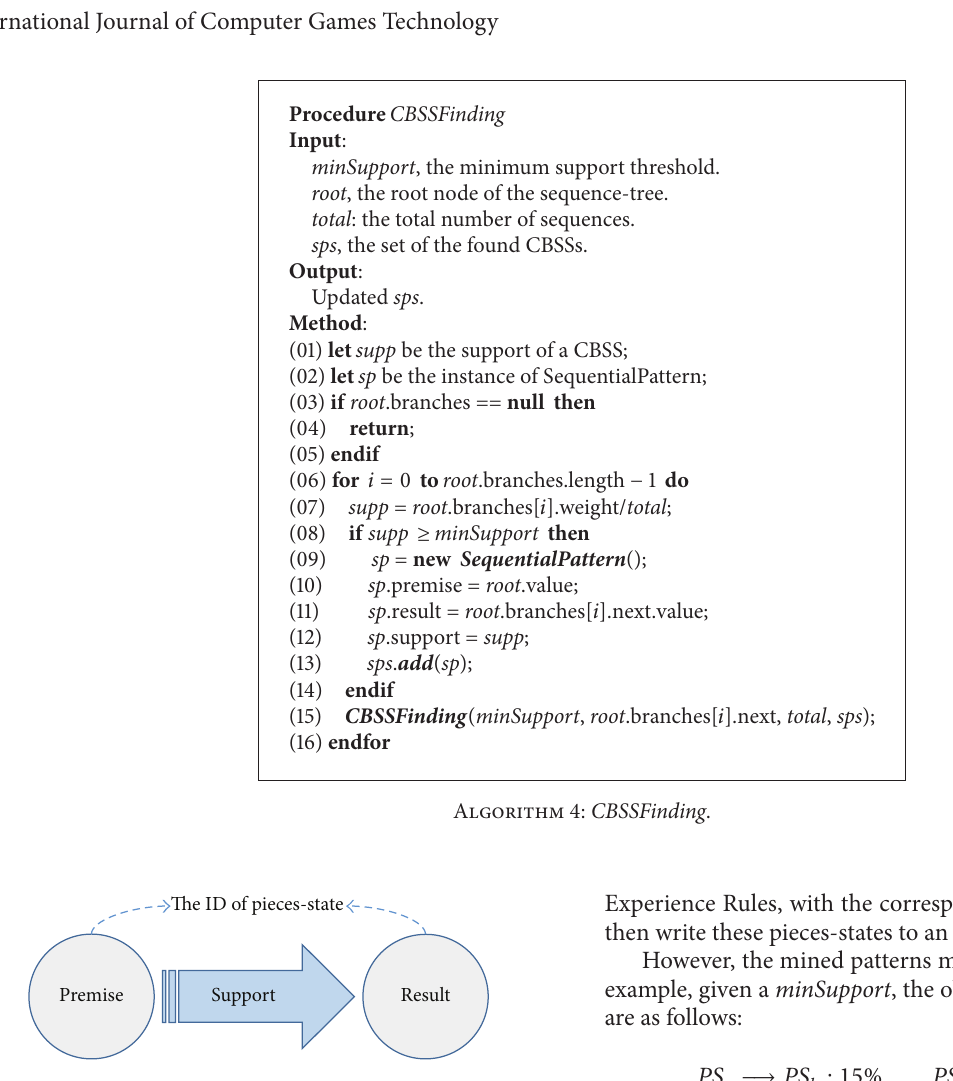
Figure 4: The structure of